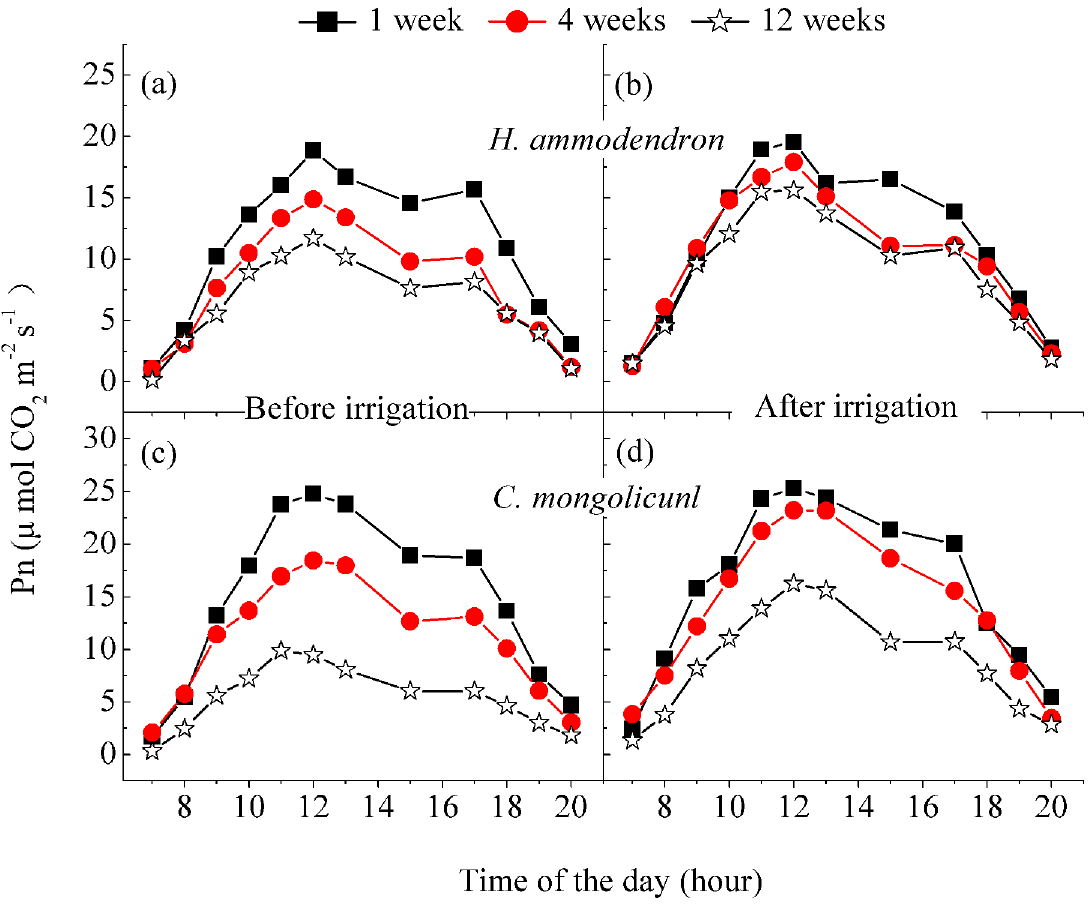
Fig 6. Diurnal photosynthesis patterns of Haloxylon ammodendron (a, b) and Calligonum mongolicunl (c, d) before and after irrigation for the five irrigation intervals. The data points for the 2-week interval fell betweenthose of the 1 and 4 weeks; those of the 8-week interval fell betweenthose of 4 and 12 weeks. Error bars represent the standarddeviationof the mean. Different lower-caseletters indicatesignificantdifferences among treatments ( P = 0.05).